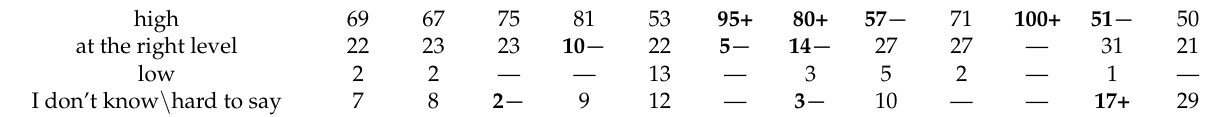
high at the right level I don’t know \ hard to say Table 3. Amount of increases in electricity prices expected by entrepreneurs—by workforce (answers in percentage points). By what percentage will energy prices increase in Poland over the next five years?